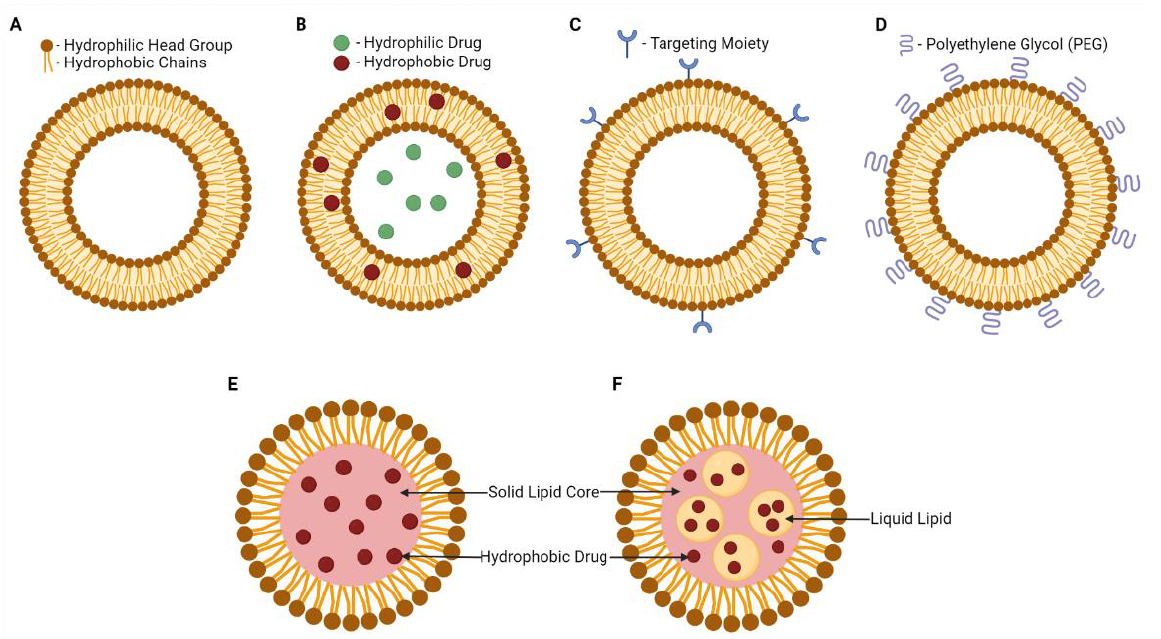
Figure 1. Visual illustration of the structures and composition of various LNPs. ( A ) Liposome. ( B ) Drug-loaded liposome. ( C ) Targeted liposome. ( D ) PEGylated liposome. ( E ) Solid lipid nanoparticle. ( F ) Nanostructured lipid carrier. Created with BioRender.com.